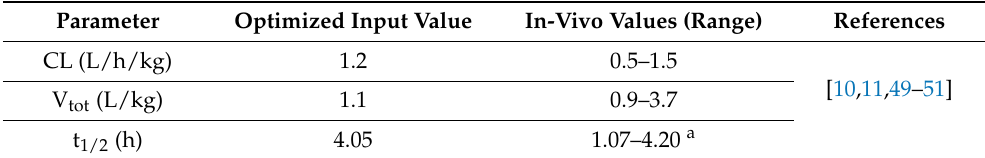
Figure 8. P eff obtained with and without the presence of tight ‐ junction modifiers (quercetin/sodium decanoate). Data are presented as the Mean ± SD; n = 5 in each experimental group, * p ‐ value < 0.05, ** p ‐ value < 0.01. Table 3. Comparison of the selected input values and literature data for minoxidil pharmacokinetic parameters.